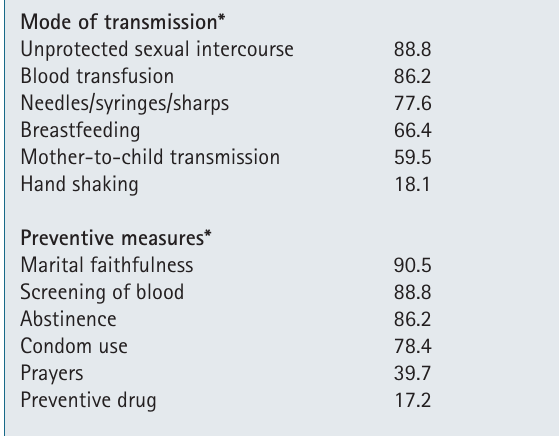
taBle ii. KnoWleDge oF MoDeS oF tranSMiSSion anD PreVention oF HiV/aiDS (%)